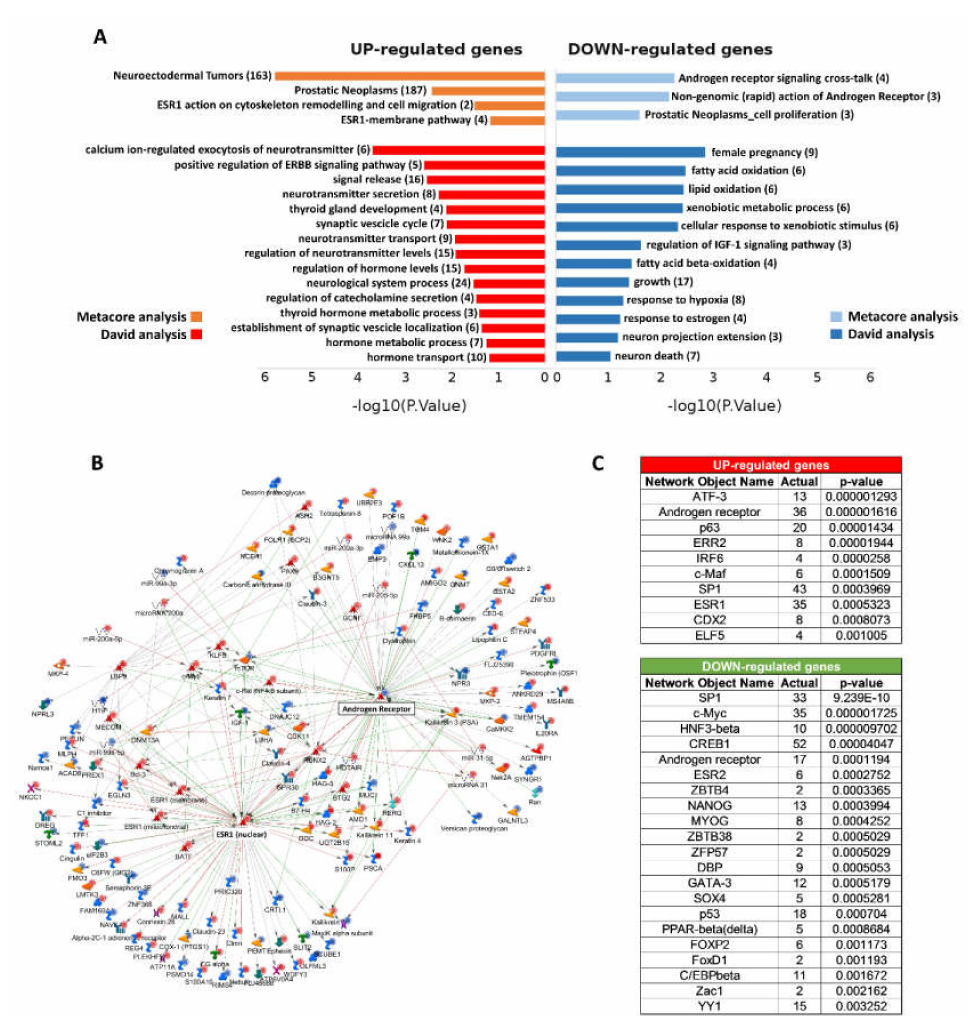
Figure 3. ( A ) A selection of pathways derived from functional enrichment analysis of DEGs using Metacore (orange and light-blue bars) and David analyses (red and blue bars). The negative logarithm of the p -value (base 10) is reported on the X-axis. FDR p -values range from 3.31 × 10 − 5 to 0.9. The number of genes involved in each process is indicated in brackets. The complete list of pathways and processes is available in Supplementary Table S1. ( B ) The network of direct interactions starting from or pointing to AR and ESR1 proteins. More in detail, 70 connections started from AR, and 12 pointed to AR, while 75 links started from ESR1, and 26 pointed to ESR1. The objects that are over- or underexpressed in the data are marked with red / blue circles, respectively. Di ff erent edge colors were used to represent the activation (green), inhibition (red), and unspecified (grey) e ff ects. ( C ) Transcription factor interactome analysis pointed out several enriched transcription factors that may putatively control a significant number of up- or down-regulated genes in the NE-live vs. AdenoPCa